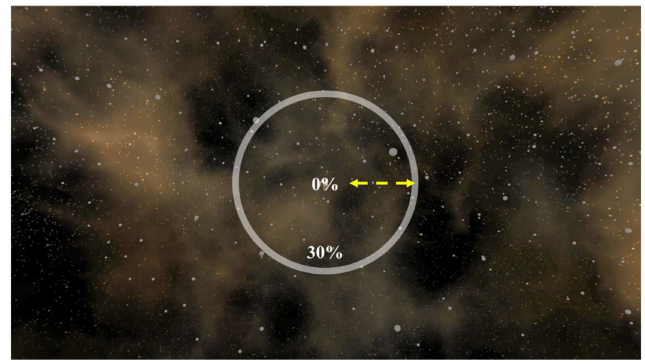
Figure 2. The second VR sickness reduction method (M2). The VG of the third VR sickness reduction method had a size 30% that of the aspect ratio, and a position that moves CW every second along the eight points. This method induced CW gaze movement through the movement of the VG. Figure 3 shows the third VR sickness reduction method (M3).